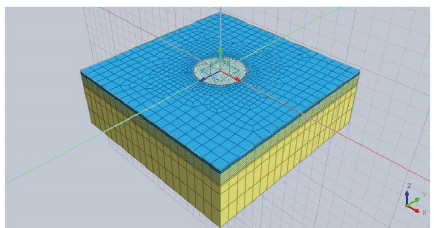
Figure 5: Grid diagram of the pit model.